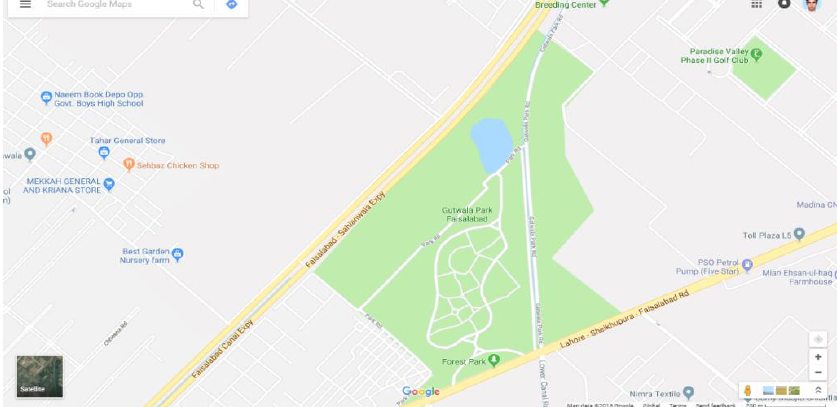
Figure 1: Geographical position of Gatwala Park located 368 ft away from the main road